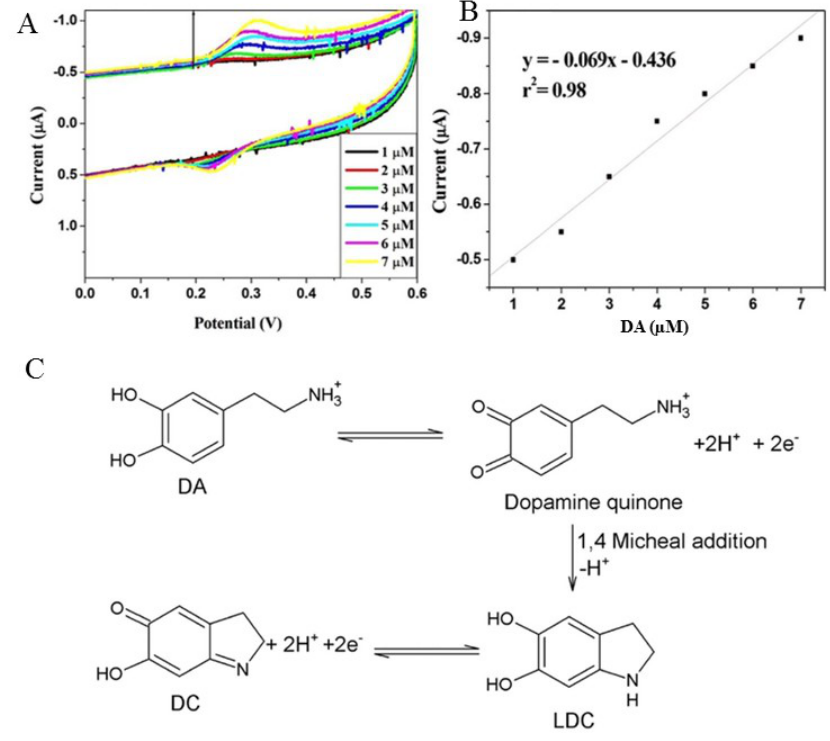
Figure 3. ( A ) CVs of DA with different concentration ( B ) The corresponding calibration plot for [DA] vs. Ipa. ( C ) Mechanism of electrochemical oxidation of DA on screen − printed carbon electrode/CQD film modified electrode. (Reproduced with permission from ref. [106]).